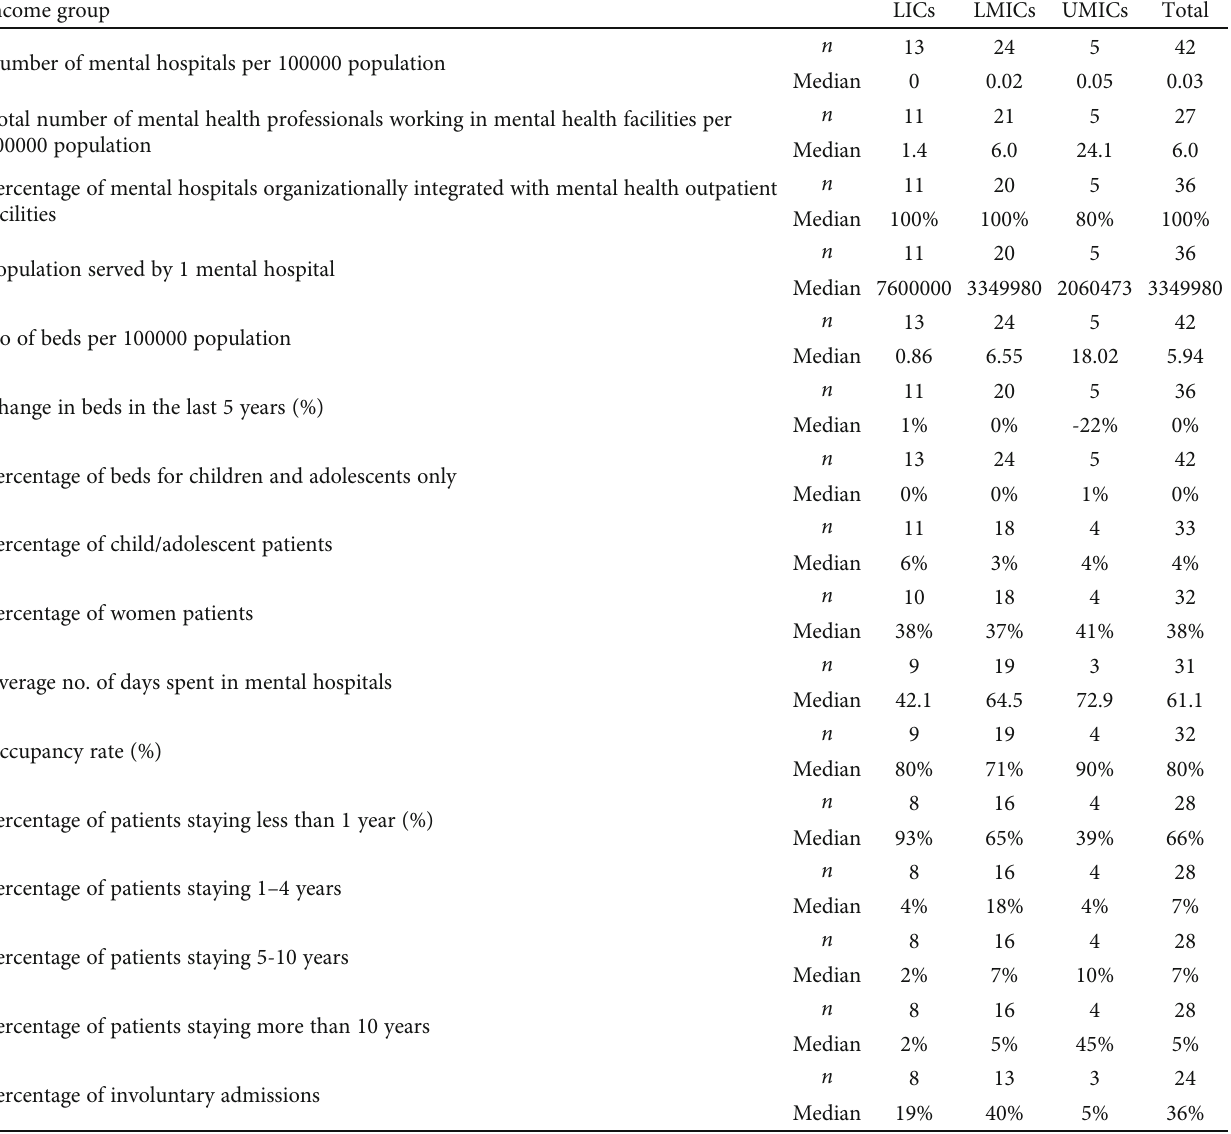
Table 5: WHO-AIMS report, summary of indicators for mental health facilities, by country income group (median